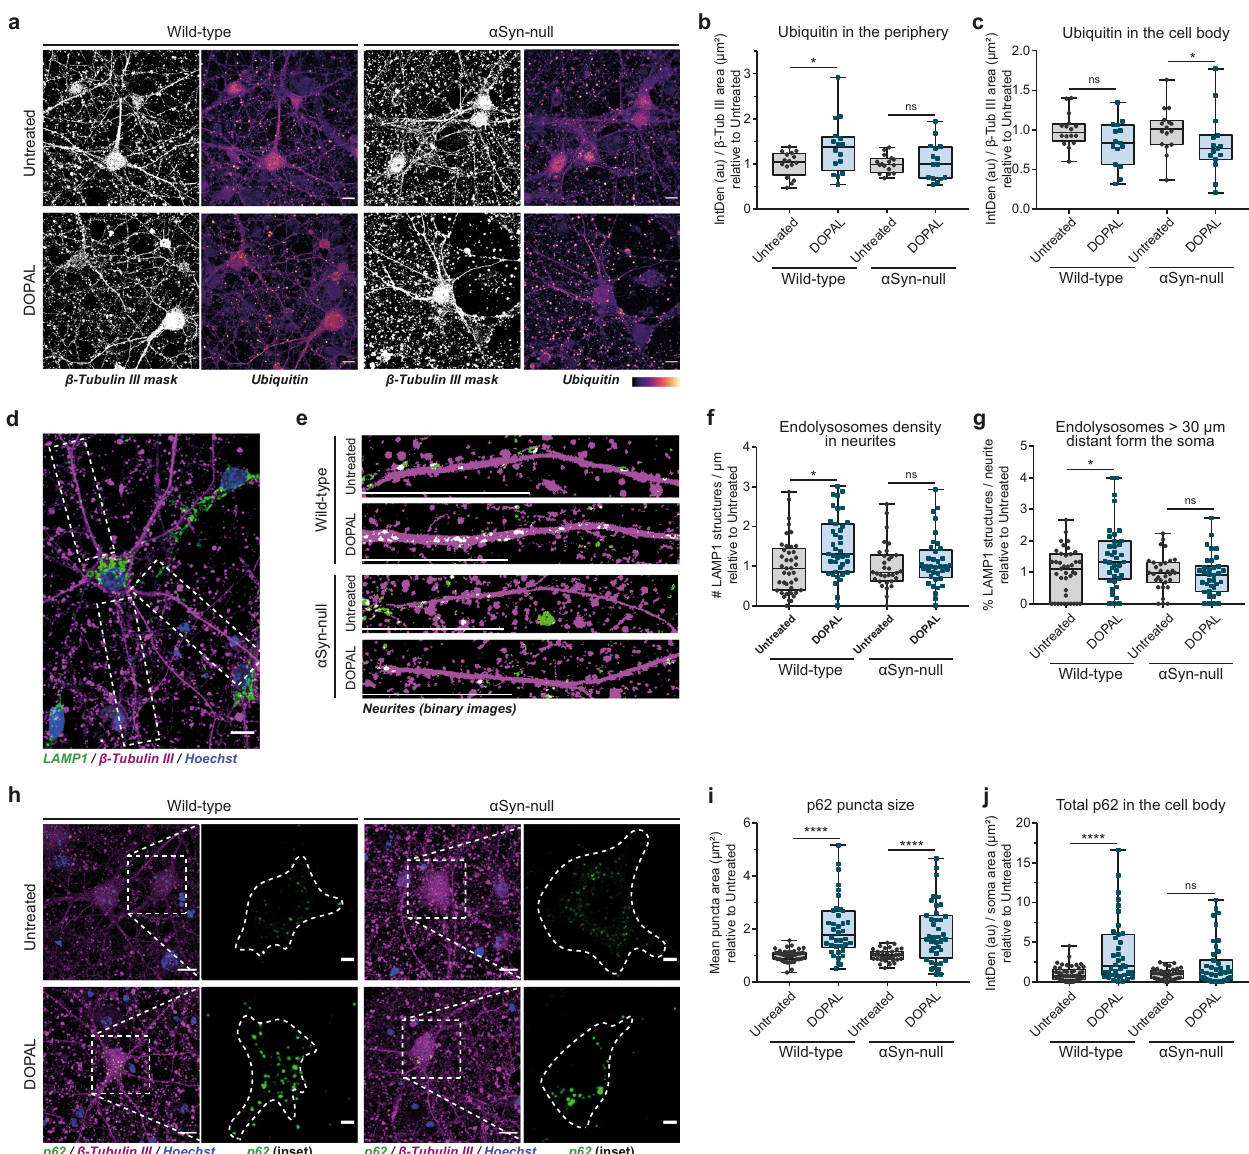
Fig. 6 α Synuclein and DOPAL act in concert to hinder neuronal proteostasis. Immuno fl uorescence analysis of proteostasis markers in untreated and 100 μ M DOPAL-treated (for 24 h) wild-type and α Syn-null primary mouse cortical neurons. a Immunostaining of β -Tubulin III (converted to binary mask) and Ubiquitin (heatmap). Scale bar: 10 µm. Quanti fi cation of the Ubiquitin fl uorescence b in the periphery and c the cell bodies, both normalized to β -Tubulin III area (µm 2 ). d Immunostaining of β -Tubulin III (magenta) and LAMP1 (green) in primary mouse neurons. Nuclei are stained with Hoechst (blue). The insets provide examples of the criteria for neurite identi fi cation for endolysosomal density analysis in neuronal projections. Scale bar: 10 µm. e In the enlargement of neurites, both β -Tubulin III and LAMP1 fl uorescence signals are converted to binary mask to emphasize the overlay (puncta in white). In the bottom left part of the images, the scale bar corresponds to 30 µm. f Endolysosomes density in neurites expressed as number of LAMP1 structures/µm 2 and g percentage of endolysosomes in proximity to the soma (<30 µm) in each neurite. h Immunostaining of β -Tubulin III (magenta) and p62 (green). Nuclei are stained with Hoechst (blue). Scale bar: 10 µm. In the inset, the p62 fl uorescence signal in the cell body is enlarged and the dotted line de fi nes the soma boundaries (scale bar: 3 µm). i Quanti fi cation of the p62-positive puncta mean size (µm 2 ) in each soma and j total p62 signal normalized to the soma area. Data from three independent experiments are normalized to each untreated sample, pooled together, and analyzed by Mann – Whitney test (* p < 0.05, **** p < 0.0001). b , c , f , g , i , j Data are displayed as box and whiskers plot showing the minimum and maximum points (whiskers), the fi rst quartile, median and third quartile (box lines). associated protein1 (LAMP1)-positive endolysosomal structures synaptic accumulation is the key event driving the engulfment of was observed in the neurites of DOPAL-treated wild-type neurons quality control machineries following DOPAL buildup. when compared to the α Syn-null neurons (Fig. 6d – f), without We then assessed whether the increased protein ubiquitination signi fi cant difference in the detected organelle size (Supplemen- in the neuronal processes correlated with the upregulation of the tary Fig. 6b). Of note, the endolysosomes in DOPAL-treated wild- endosomal pathway to transport aberrant proteins to the type neurons accumulated mainly in the distal portion of the lysosomal degradation in the soma, as we observed for the MVBs neurites (distance >30 µm from the soma, Fig. 6g), supporting our by CLEM. Consistently, an increased density of lysosomal Published in partnership with the Parkinson ’ s Foundation npj Parkinson’s Disease (2023)